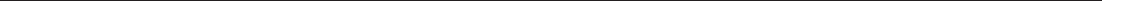
Table 2. Despite the non-significant p-value and wide confi-